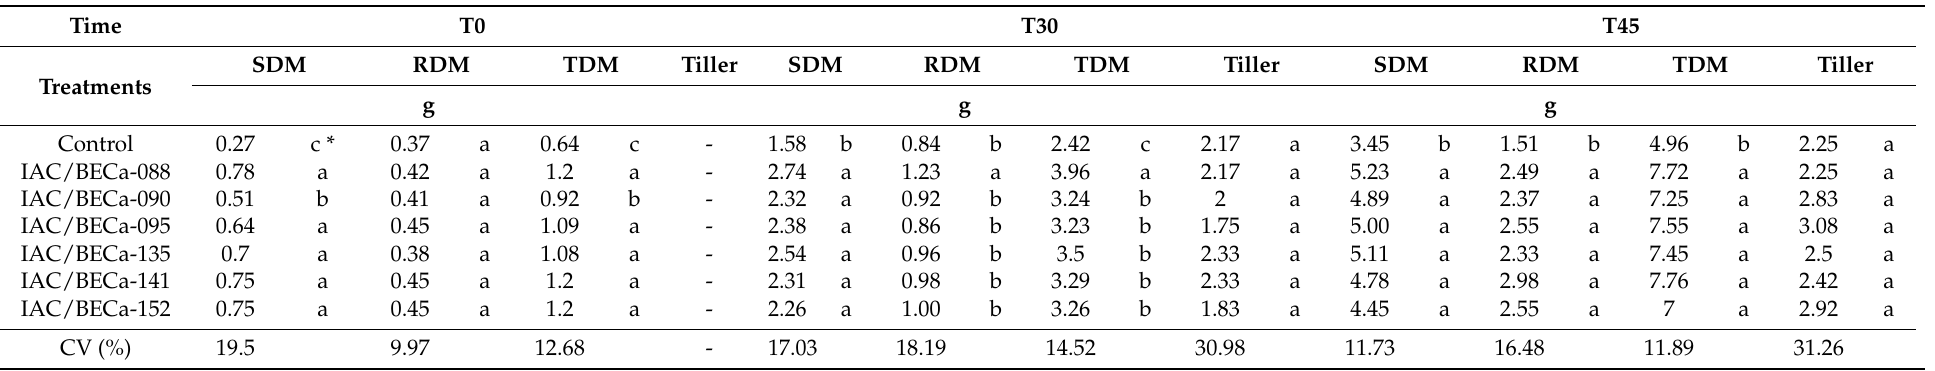
Table 2. Shoot dry matter (SDM), root dry matter (RDM), total dry matter (TDM), and number of tillers of sugarcane seedlings inoculated or not (control) with six different bacterial inoculant day of transplanting (T0), 30 (T30) and 45 (T45) days after transplanting. Time T0 Treatments